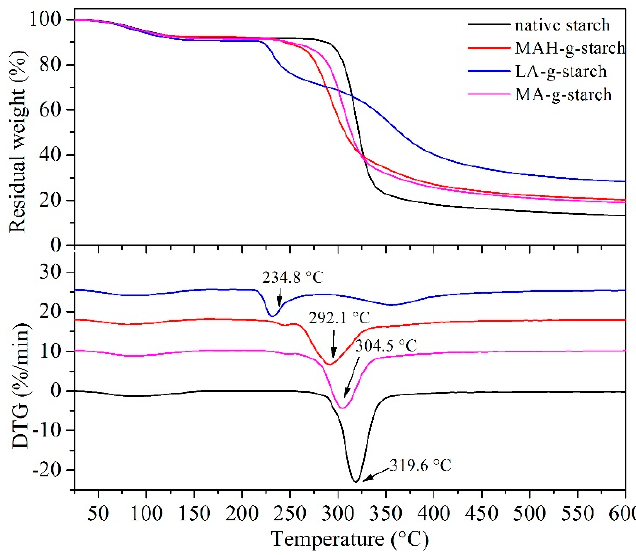
Figure 8. TGA and DTG curves of native starch and grafted starches.